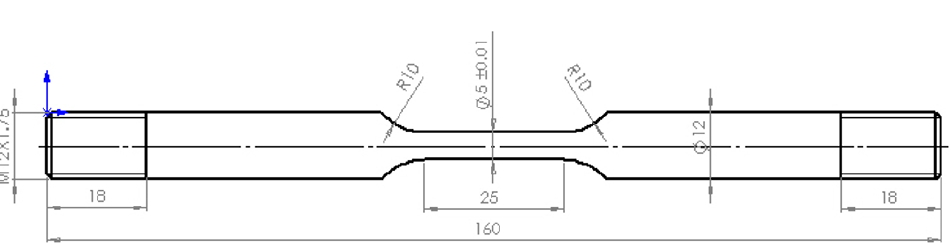
Figure 1. Shape and size of the corrosion fatigue specimens.